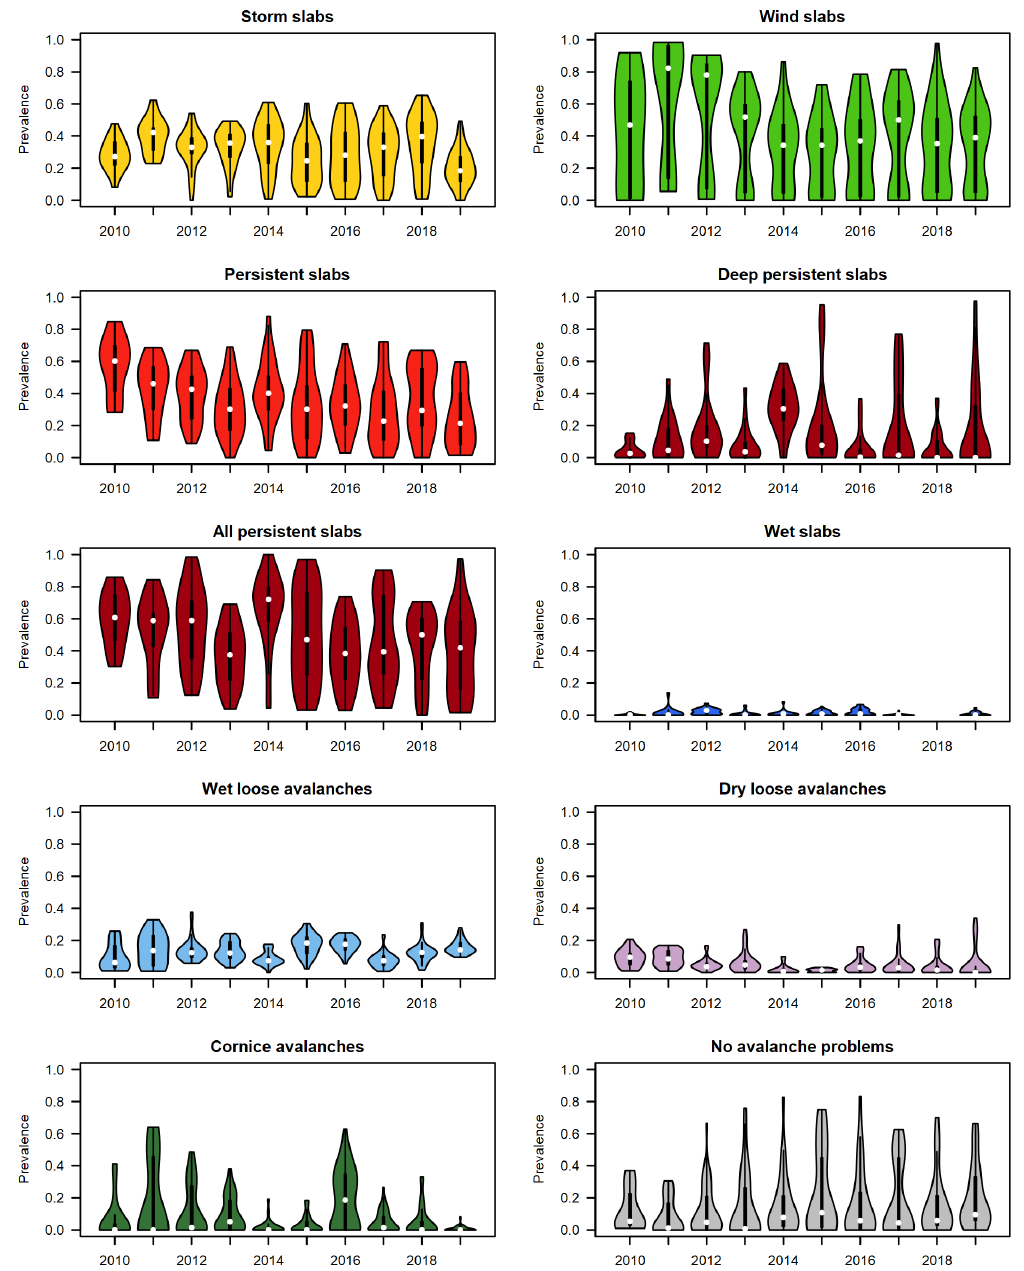
Figure 2. Time series of violin plots illustrating changes in the seasonal distributions of prevalence values for each avalanche problem type. Each violin plot represents the observed prevalence values from all regions and elevation bands (18 observations in 2010 and 2011; 45 observations per winter thereafter). White dots in violin plots represent the median, and thick black lines show interquartile